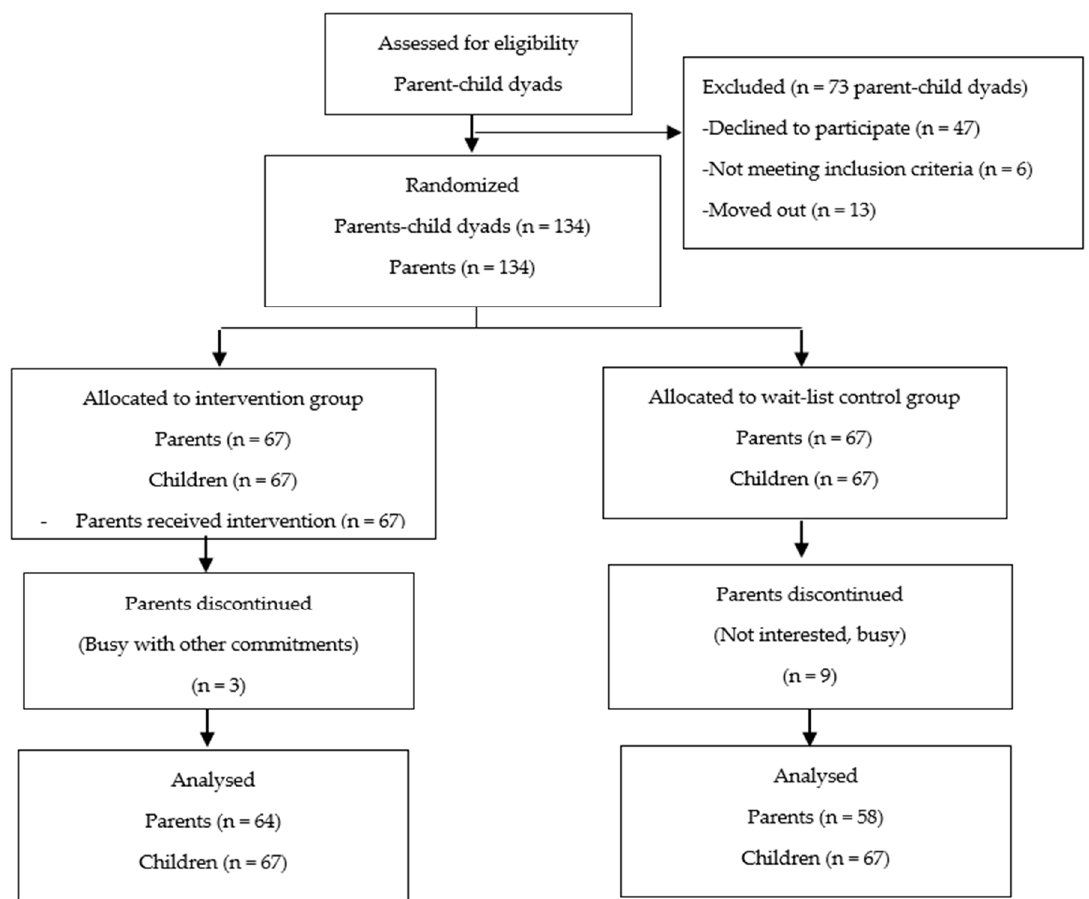
Figure 1. Study flow chart and Consolidated Standards of Reporting Trials (CONSORT) diagram of parent–child participation of REDUCE (REorganise Diet, Unnecessary sCreen time and Exercise) randomized controlled field trial .